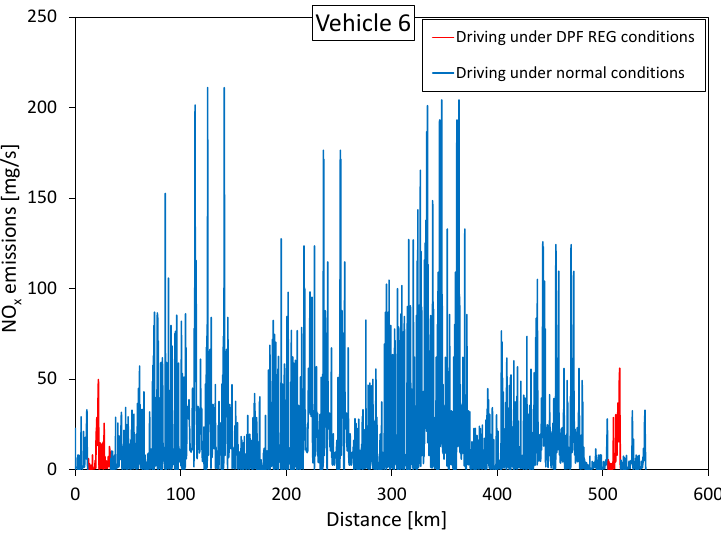
Figure 11. Instantaneous NO x emissions during testing of Vehicle 6.